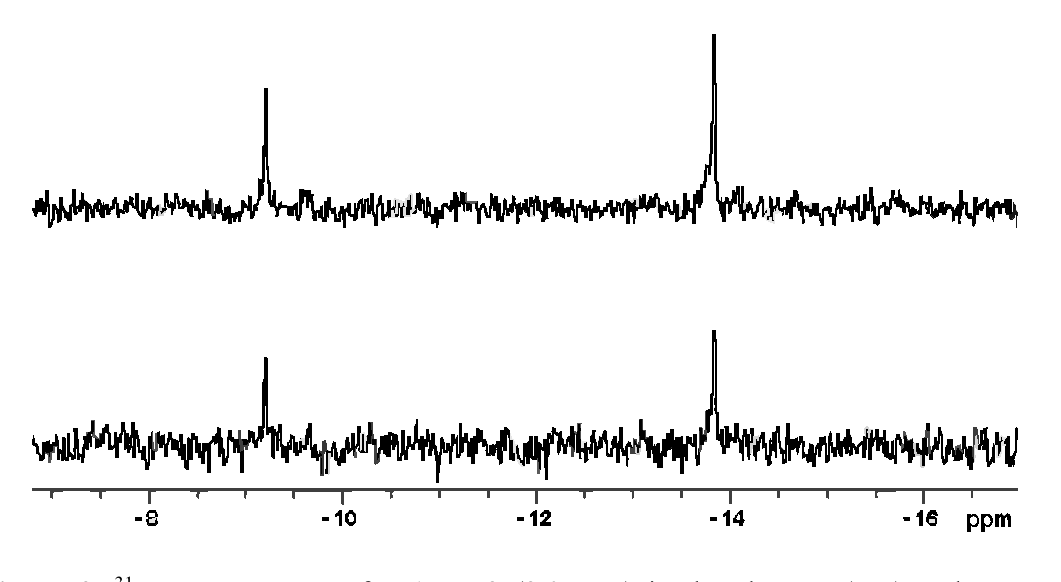
Figure 3. 31 P NMR spectra of Zr1-WD2 (2.0 mM) in the absence ( top ) and presence (bottom ) of HSA (0.2 mM) in phosphate buffer (10 mM, pH 7.4, 10% D 2 O). The peak positions at − 9.33 and − 13.94 ppm do not change upon addition of